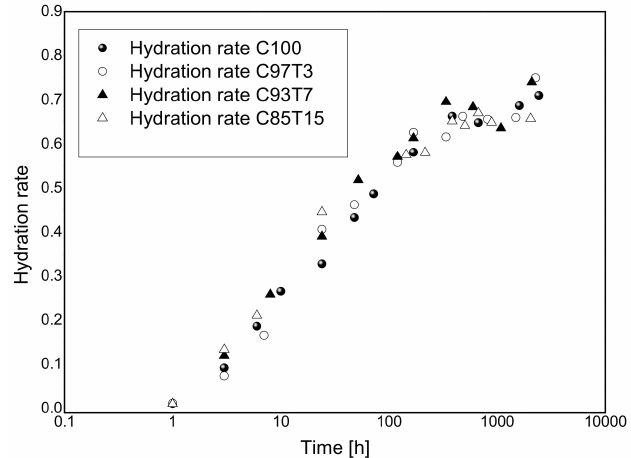
Figure 2. Normalized hydration rates of the four samples with respect to the fully hydrated C100R